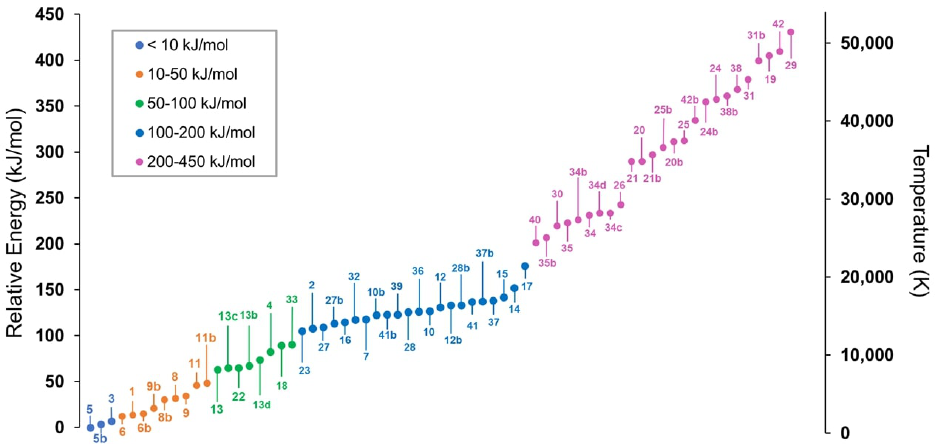
Figure 1. Relative energies of the 67 isomers of the C 3 H 3 NO family as obtained from the revDSD/junTZ level of theory, including the hZPE contribution. The reader may refer to the SM for the correspondence between the labeling and the molecular